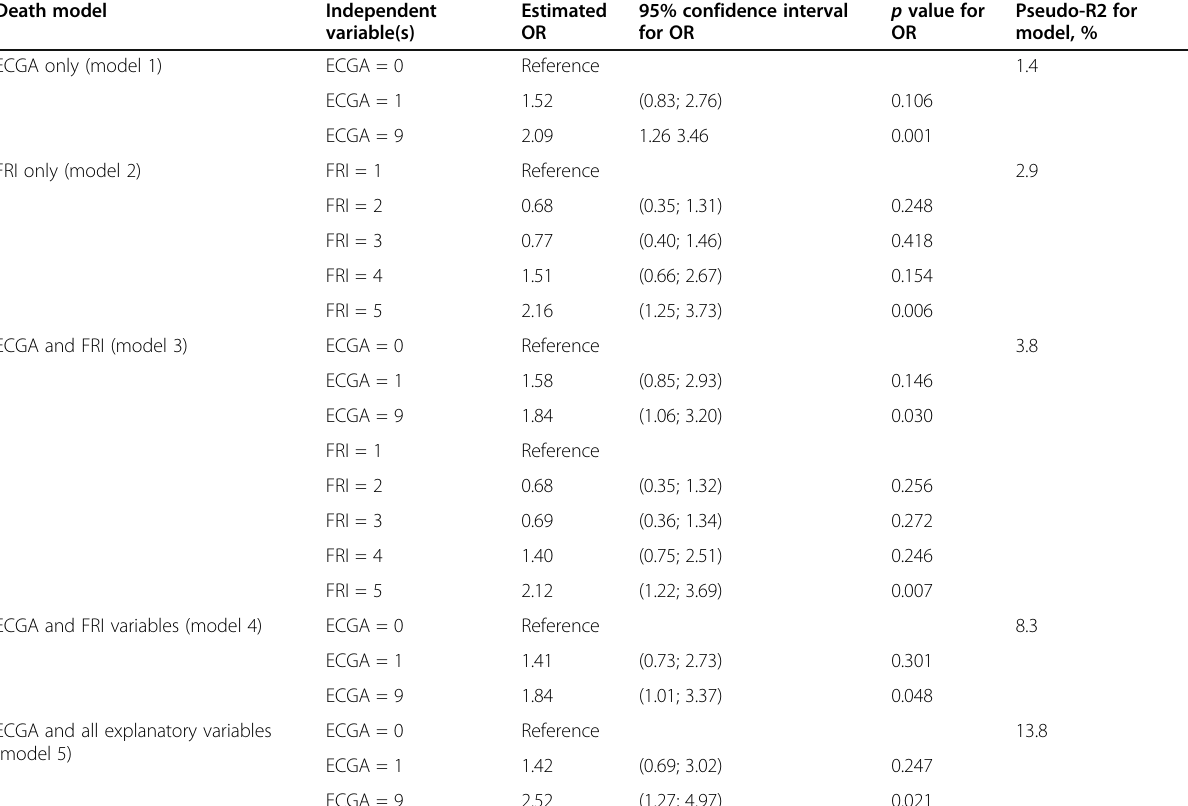
Table 6 Results for regression models with death as a dependent variable with ECGA and additional independent variables of the 977 cohort participants of men aged 45 – 50 at baseline in 1993 followed for 25 years Death model Independent